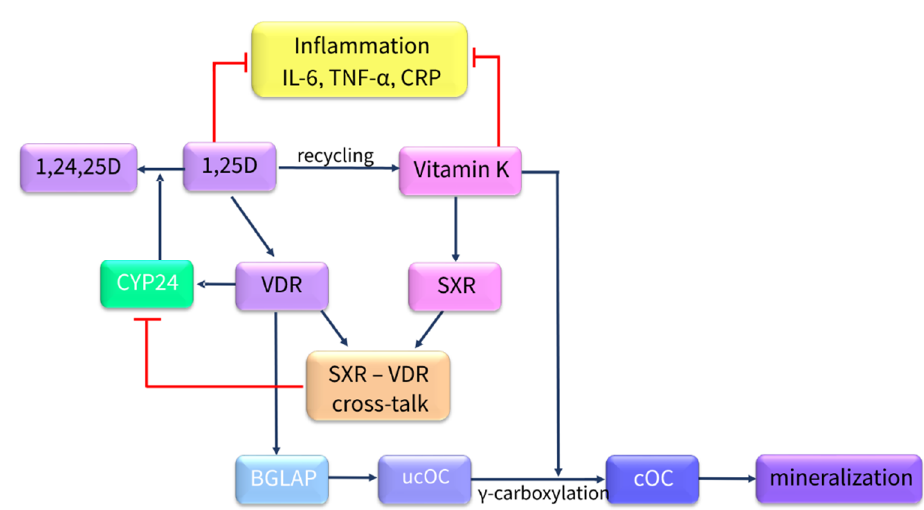
Figure 5. Potential synergy between vitamin K and vitamin D action in bone. Abbreviations: IL-6, interleukin 6; TNF-α, tumor necrosis factor α; CRP, C-reactive protein; 1,24,25D, 1,24,25-trihydroxyvitamin D; 1,25-dihydroxyvitamin D; CYP-24, 25-hydroxyvitamin D-24α-hydroxylase; VDR, vitamin D receptor; SXR, steroid and xenobiotic receptor; BGLAP, bone-Gla-protein; ucOC, uncarboxylated osteocalcin; cOC, carboxylated osteocalcin.